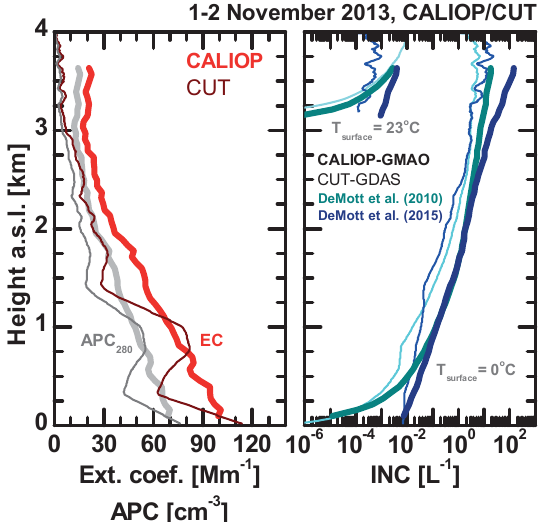
Figure 13. Same as Fig. 10, except for a Middle East desert dust outbreak on 1–2 November 2013. In the case of CALIOP profiles (180km east of Limassol), again, 135 signal profiles (45km hori- zontal resolution) are averaged, collected during seconds 8–14 of 23:47UTC on 1 November 2013. The CUT lidar profiles show av- erage values for the time period from 00:00 to 00:59UTC on 2 November 2013. The original GDAS and GMAO temperature and pressure profiles were used in the computation of the INC profiles indicated by T surface = 23 ◦ C. The GDAS and GMAO temperature profiles were shifted by 22K (Limassol) and 23K (CALIOP) in the case of the INC curves indicated by T surface = 0 ◦ C. Uncertainties are on the order of 20% (for σ d ), 30% (for APC 280 ), and within a factor of 3 (for INC) when using the dust INC parameterization after DeMott et al.